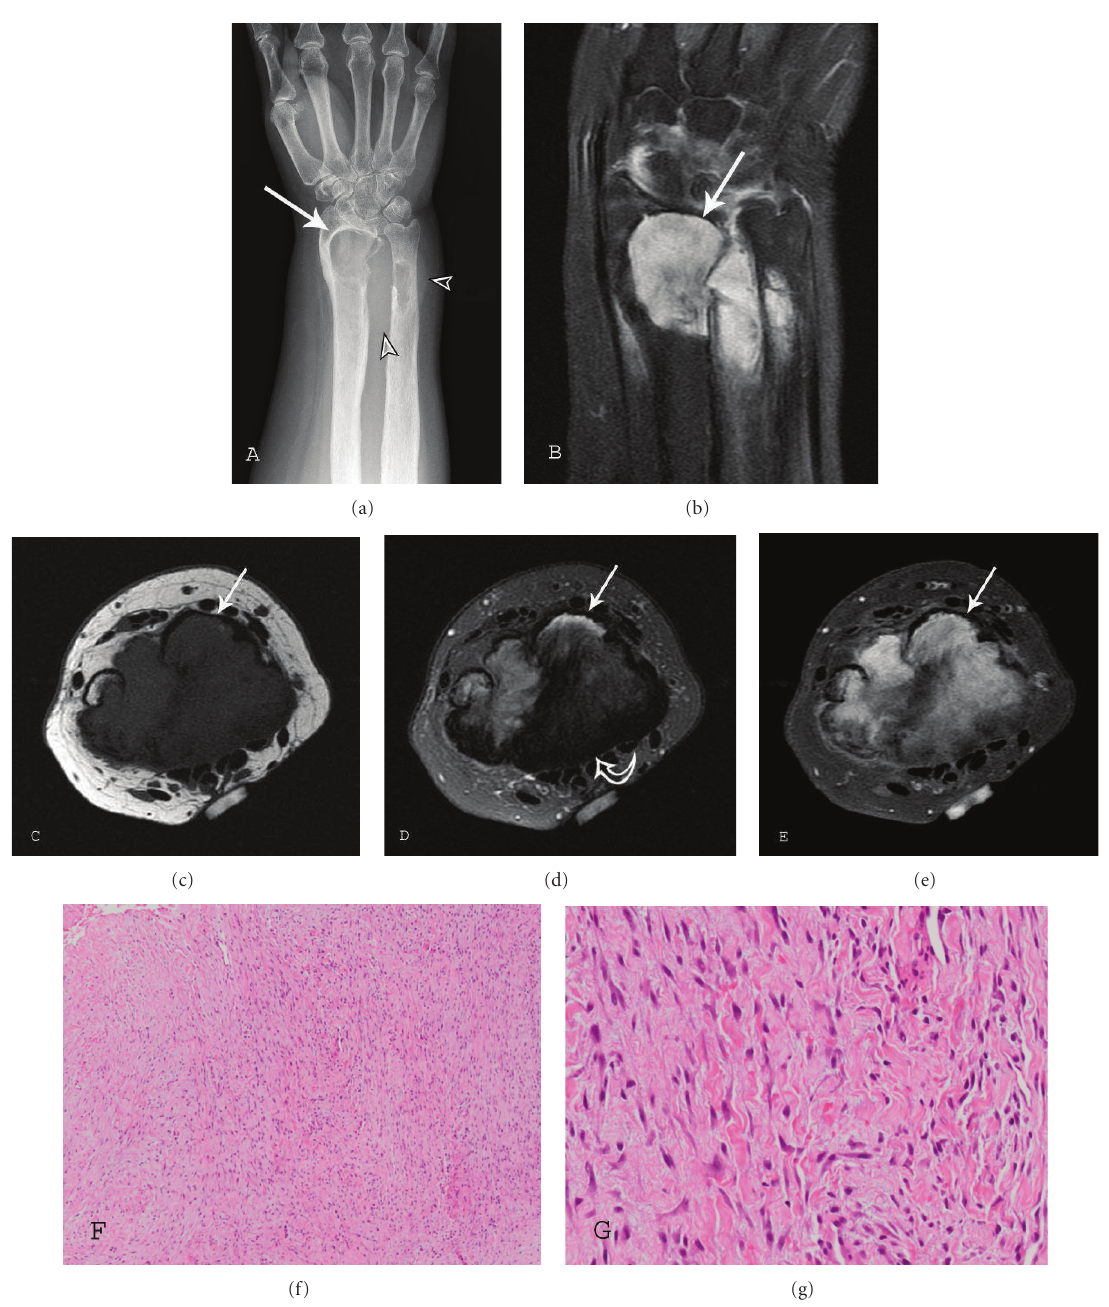
Figure 6: Extraabdominal fibromatosis of the right forearm with osseous involvement: a 47-year-old female with recurrent right distal forearm desmoid. (a) AP radiograph and (b) coronal T1-weighted (TR452/TE6.24) fat saturation (FS) postcontrast image demonstrate a distal forearm soft tissue mass (arrows) with involvement of the distal radius and ulna. Note the soft tissue density (arrowheads) on the radiograph. Axial (c) T1-weighted (TR428/TE9.5), (d) T2FS (TR3263/TE68.3), and (e) T1FS postcontrast sequences reveal a volar soft tissue mass deep to the flexor tendons with deep invasion and marrow replacement of the distal radius (arrows) and ulna. Low-signal, predominantly collagenous component (curved arrow) is best appreciated on the T2 fat suppression image. Photomicrographs (f) low- and (g) high-power hematoxylin-eosin (H-E) stain reveal spindled or stellate cells with bland nuclear features in a background of thick collagenous